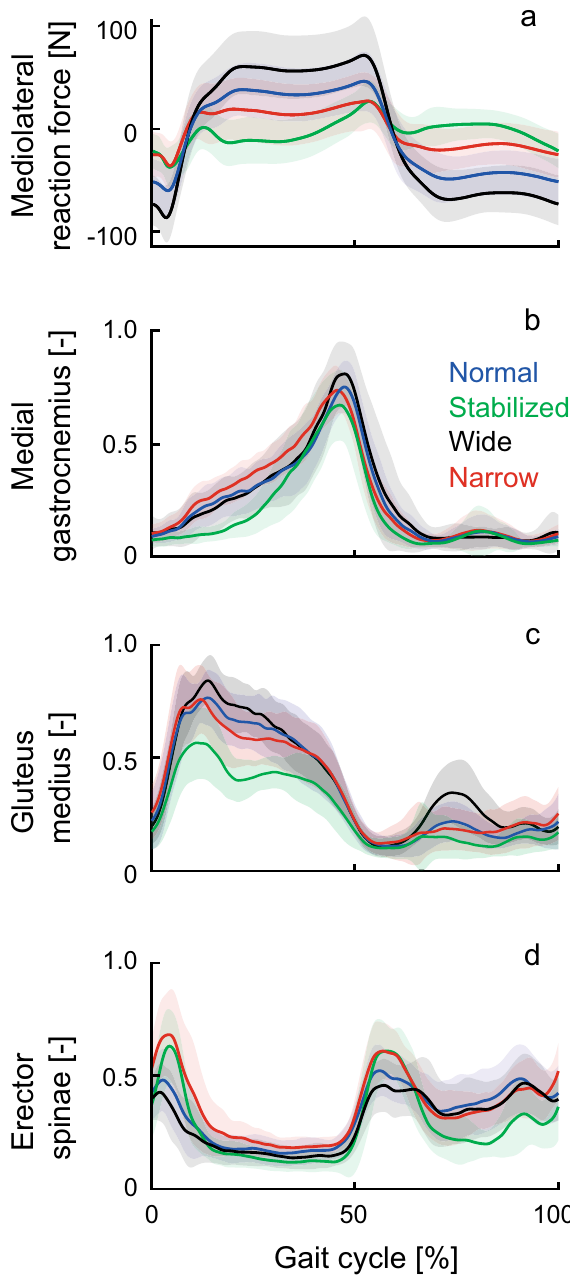
Figure 2. Ground reaction force and electromyographic amplitudes throughout the gait cycle during normal walking (blue line), walking with external lateral stabilization (green line), wide-base walking (black line) and narrow-base walking (red line). Mean values (lines) and standard deviation (shadowed area) of the ground reaction force ( a ) and the EMG envelopes of the medial gastrocnemius ( b ), gluteus medius ( c ) and erector spinae ( d ) muscles for all conditions. For each muscle, EMG signals were normalized to the maximum amplitude across all